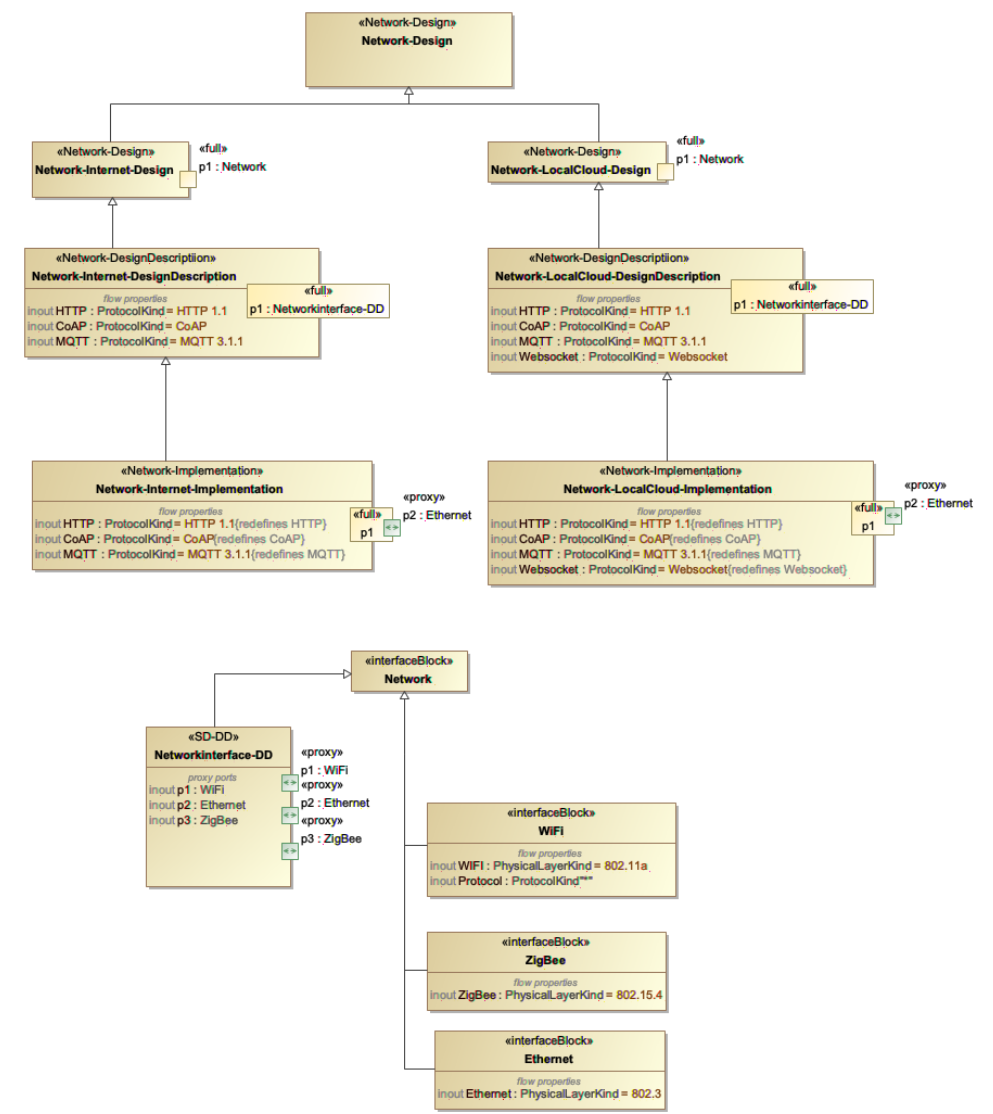
Figure 9. Black box, white box, and implementation models of the open internet structure and the private network